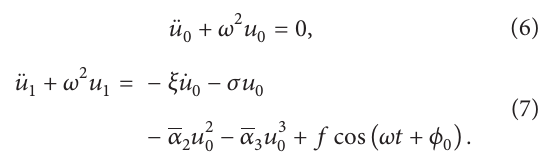
approximate solution for (4) is given by 𝑥 1 = 𝑢 0 + 𝜀𝑢 1 and thus ̇𝑥 1 = ̇𝑢 0 + 𝜀 ̇𝑢 1 and ̈𝑥 1 = ̈𝑢 0 + 𝜀 ̈𝑢 1 . Here the